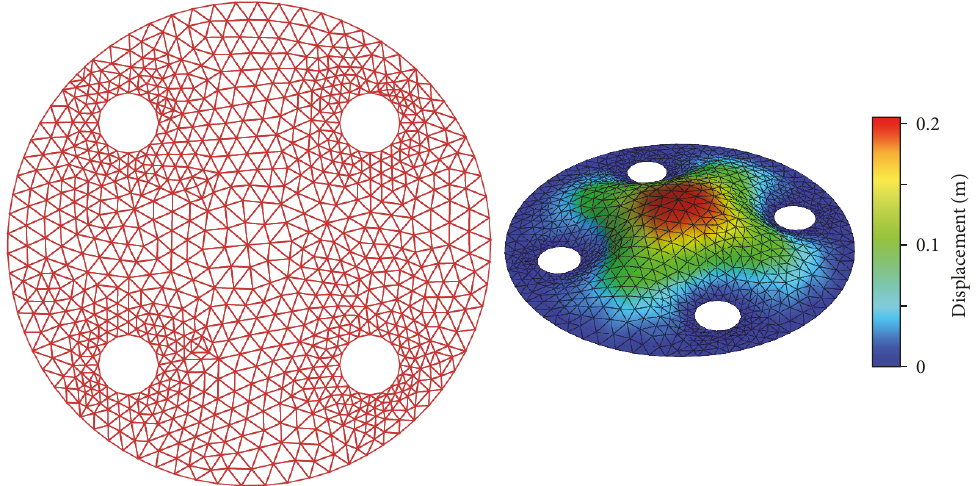
Figure 6: The circular Cosserat clamped plate of radius 𝑅 = 1.0 m and thickness ℎ = 0.1 m made of polyurethane foam with circular clamped holes under the uniform load: the initial mesh and the isometric view of the resulting vertical deflection of the plate.